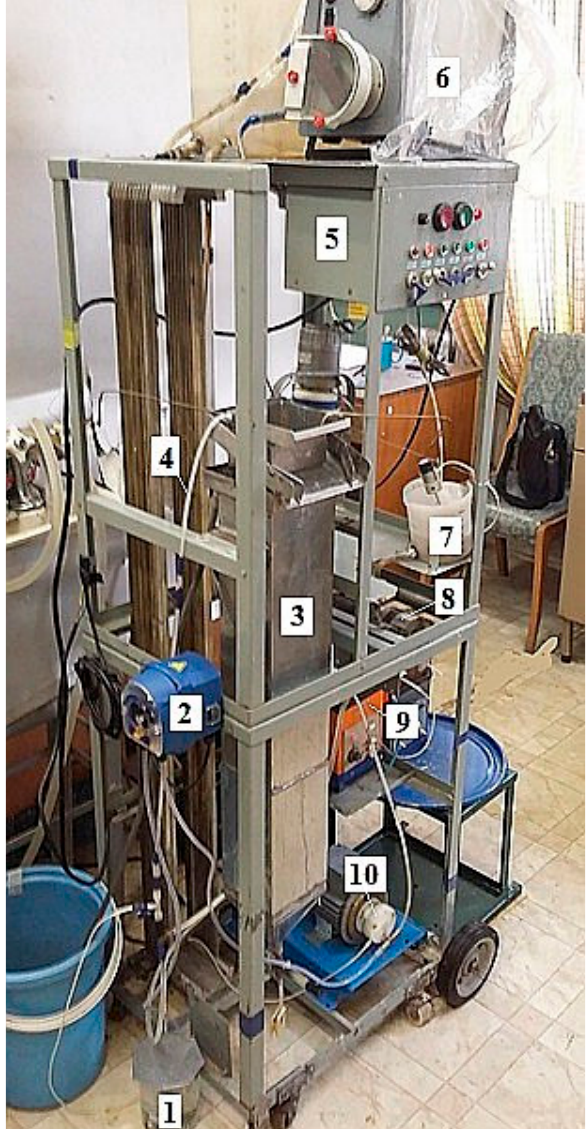
Figure 2. Laboratory rig designed for studying the process of the column flotation: 1—PPG-600 solution, 2—PPG-600 solution dosing pump, 3—flotation column, 4—tubular flotation reactor (TFR), 5—control panel, 6—pump for air supply into the column, 7—container for mineral suspension, 8—feeding pump, 9—air dosing device, 10—air-in-water dispersion generator MBGen-0.001.